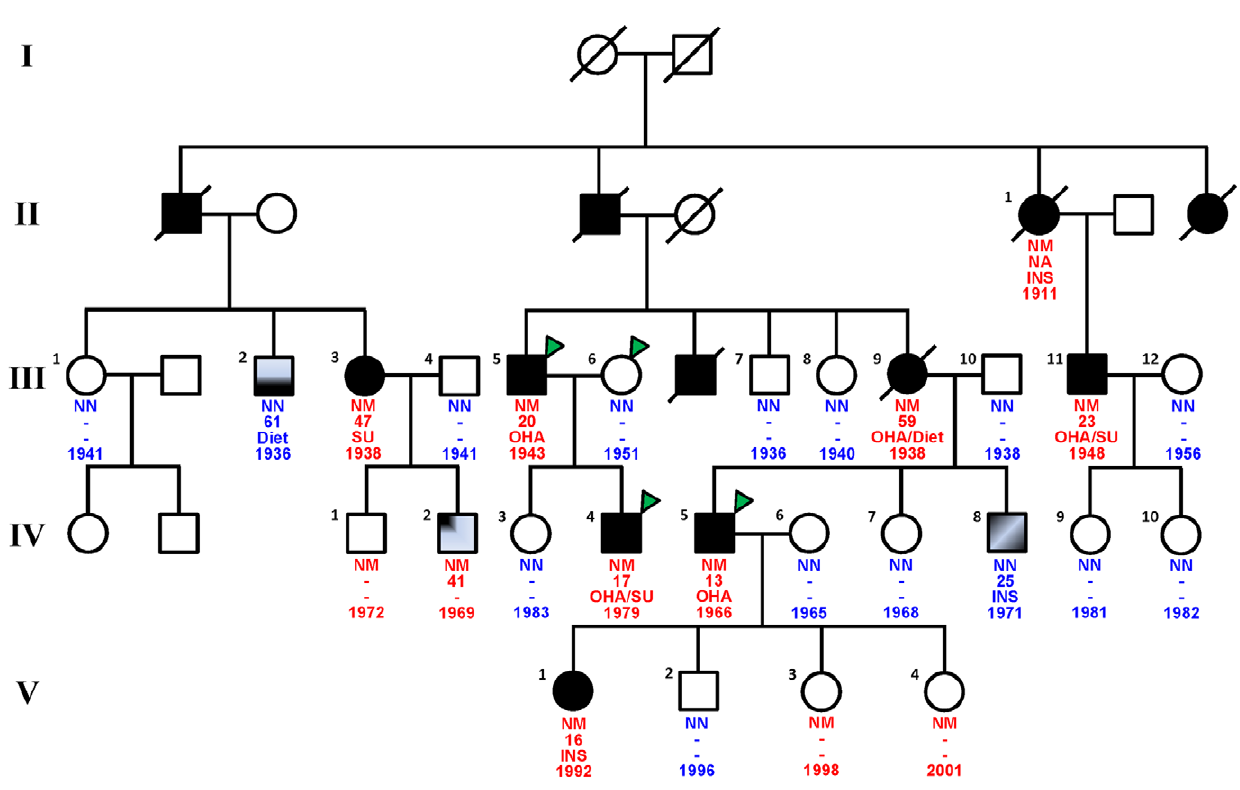
Figure 1. Pedigree of the family showing diabetes status of each member, as well as genetic status, age of diagnosis, treatment and date of birth. With regard to the genetic status, NM denotes the presence of the heterozygous KCNJ11 p.Glu227Lys mutation and NN denotes the absence of mutation at the same locus. Circles represent female participants and squares male participants. A slash through the symbol indicates that the family member is deceased. Black symbols indicate patients with non autoimmune diabetes. The half-filled and quarter-filled symbols indicate individuals with impaired glucose tolerance and impaired fasting glucose, respectively. The black symbols with a white diagonal denote patients with type 1 diabetes. Green arrows point to members for whom the whole-exome was sequenced. INS , insulin; OHA , oral hypoglycaemic agents; SU , sulfonylurea.